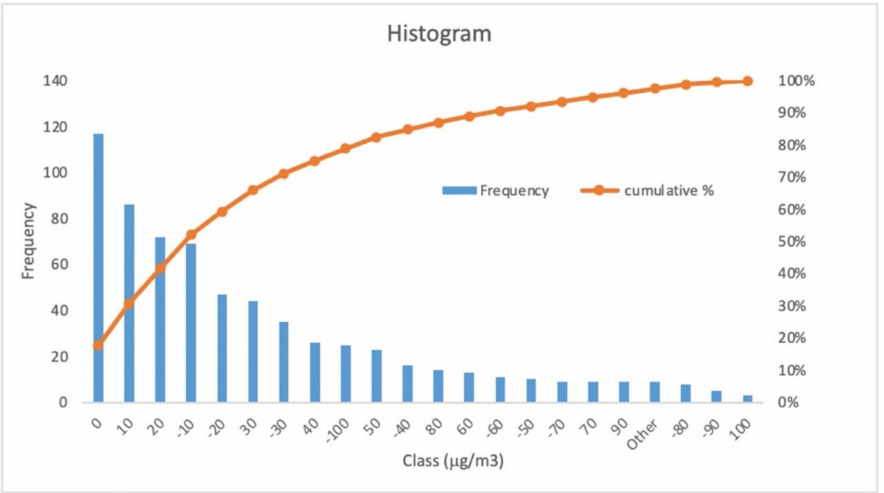
Figure 12. Histogram of the frequency of the differences of hourly modelled NOx concentrations vs. ob Scheme 3 . 2. Passenger car simulations (Sim 2 and Sim